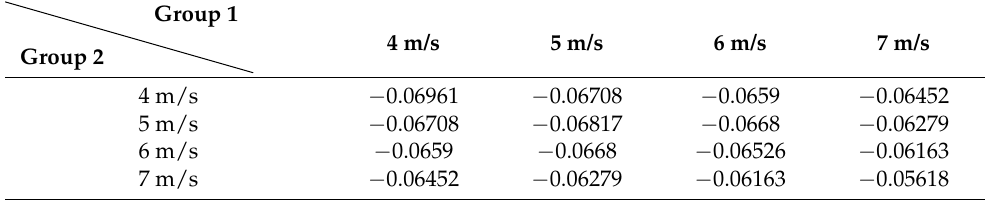
Table A9. Damping coefficient for TM4 of SG under different operating